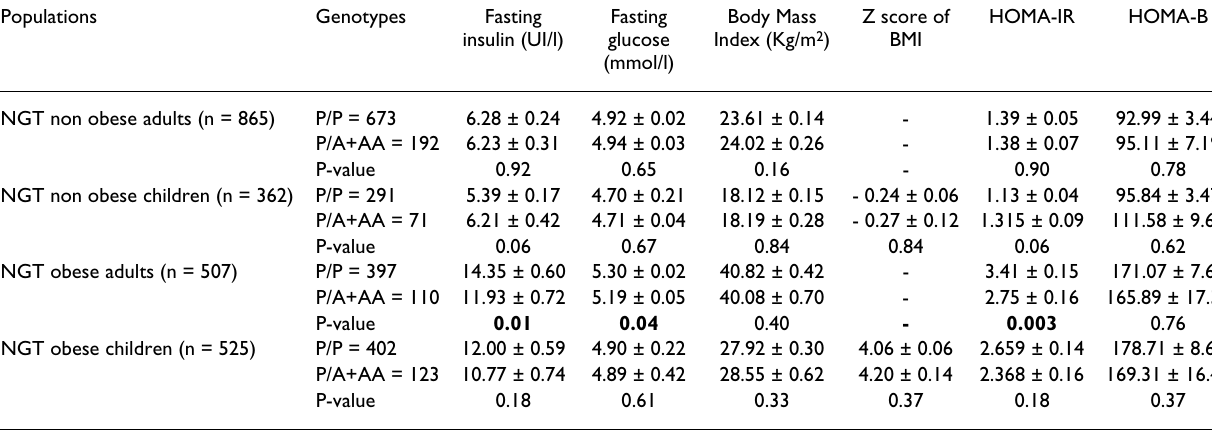
Table 4: Biochemical parameters of subjects according to Pro12Ala genotypes. Populations